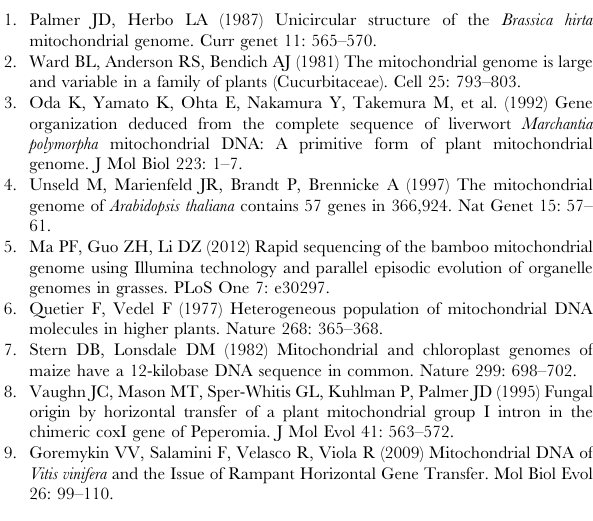
tree (B) were based on NADH dehydrogenase genes. The ML tree (C) and the NJ tree (D) were based on cytochrome c biogenesis genes. (TIF) Figure S2 Phylogenetic trees of ATPase genes. The ML tree (A) and the NJ tree (B). (TIF) Figure S3 Phylogenetic trees of apocytochrome b genes and cytochrome c oxidase genes. The ML tree (A) and NJ tree (B) were based on apocytochrome b genes. The ML tree (C) and the NJ tree (D) were based on cytochrome c oxidase genes. (TIF) Table S1 Partial primers of PCR in genome assembling. (DOC) Table S2 Genes annotated in the Gossypium hirsutum mt genome. Table S3 Size of shared sequences among 25 plant mt genomes. (XLS) Table S4 Information of genes in phylogenetic tree. (DOC) Table S5 Information of mitochondrial genomes involved in this study. (DOC)